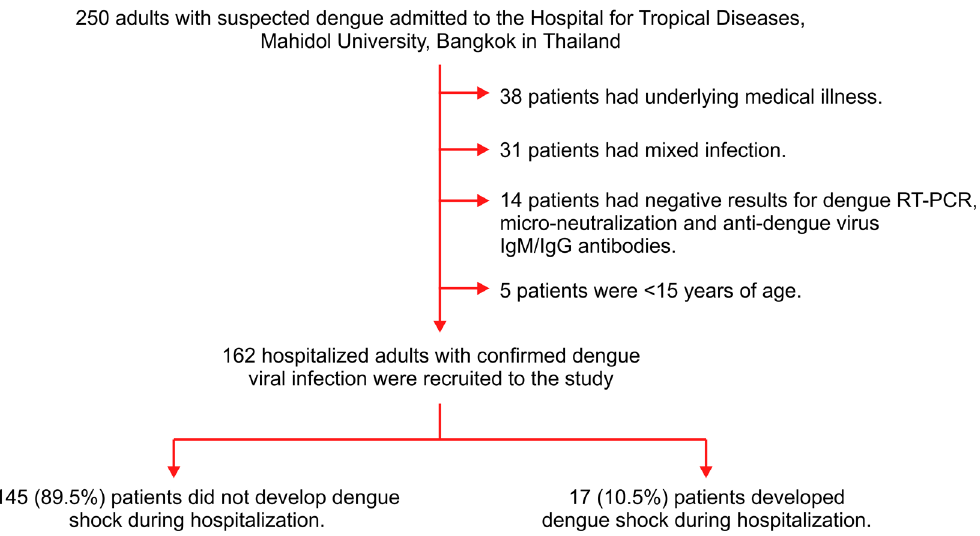
Fig 1. Flow diagram for the recruitment of study